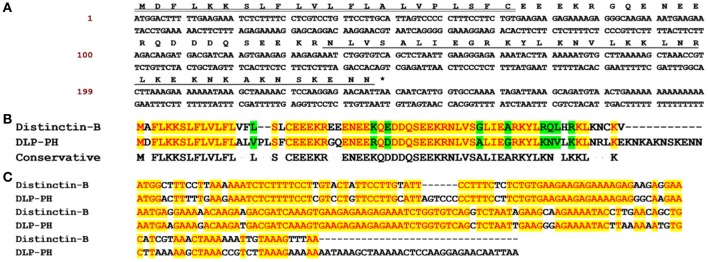
The biosynthetic precursor of DLP-PH and the comparison with Distinctin-B. (A) Nucleotide and translated open-reading frame amino acid sequence of a cDNA encoding the DLP-PH precursor cloned from a P. hypochondrialis skin secretion library. The predicted mature peptide is single underlined, the signal peptide is double-underlined and the stop codon is indicated by an asterisk. (B) The alignment of amino acid sequences of distinctin-B and DLP-PH precursors. (C) The alignment of corresponding precursor-encoding cDNA sequences. Conserved residues/bases are indicated in red with a yellow highlight. Similar residues are highlighted in green.